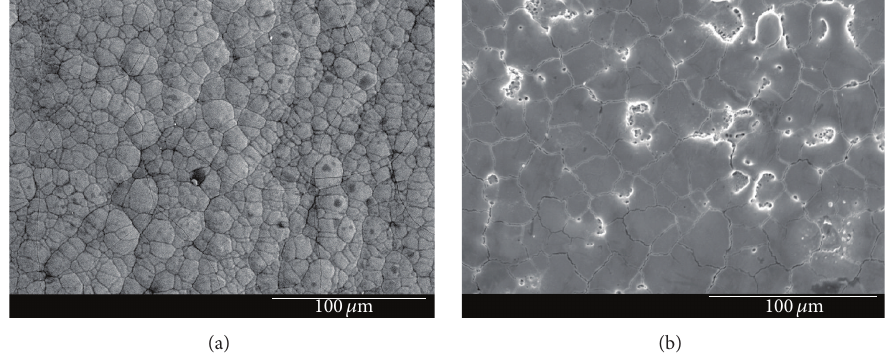
Figure 1: View of the surface morphology of Cr coating before (a) and after (b) HCPEB treatment. The images are obtained by SEI technique.